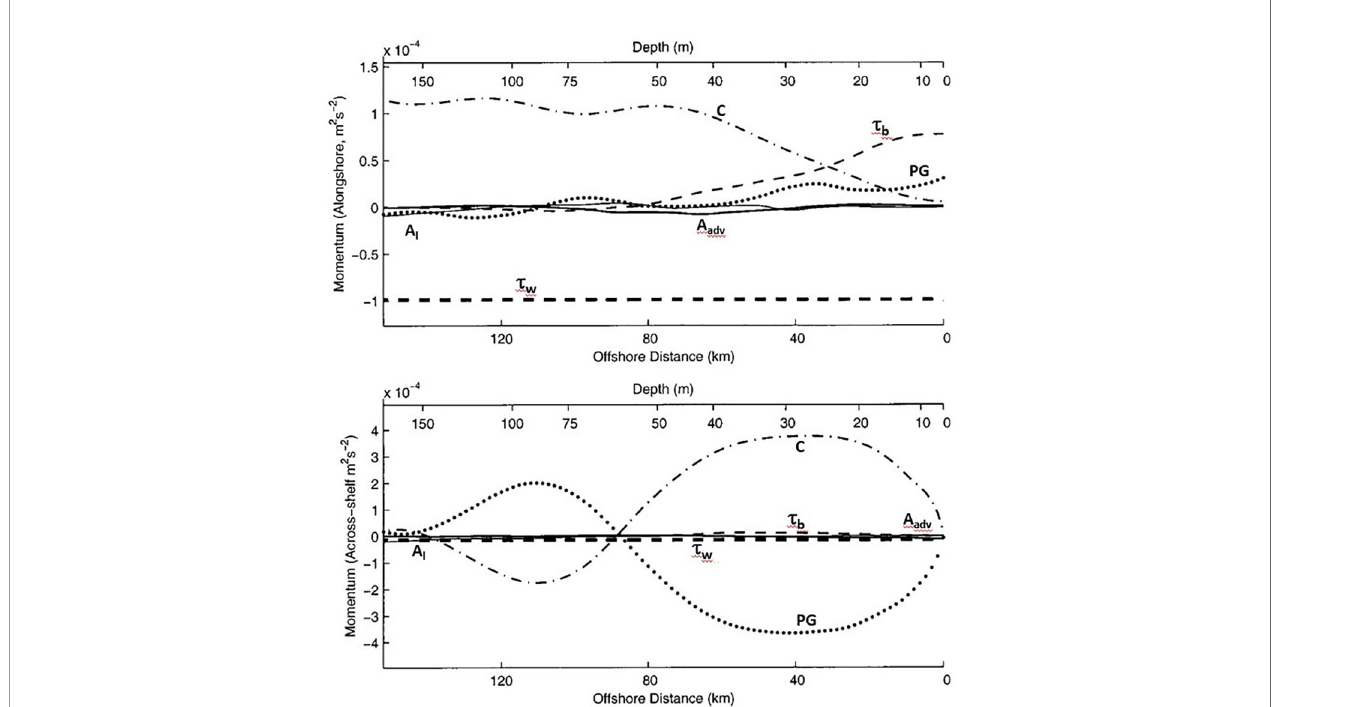
FIGURE 3 | Terms in the vertically integrated momentum balance at quasi-steady state for an initial value problem in which the WFS is forced from rest by an upwelling favorable wind stress in an application of the Princeton Ocean Model (from Li and Weisberg, 1999b). The top panel is for the along-shelf direction and the bottom panel is for the across-shelf direction. The dotted line is the pressure gradient term (PG), the dot-dashed line is the Coriolis term (C), the plain-dashed line is the bottom stress ( t b ), and the bold-dashed line is the surface stress ( t w ). The bold-solid and the plain solid lines are the advective (A adv ) and local (A l ) acceleration terms,